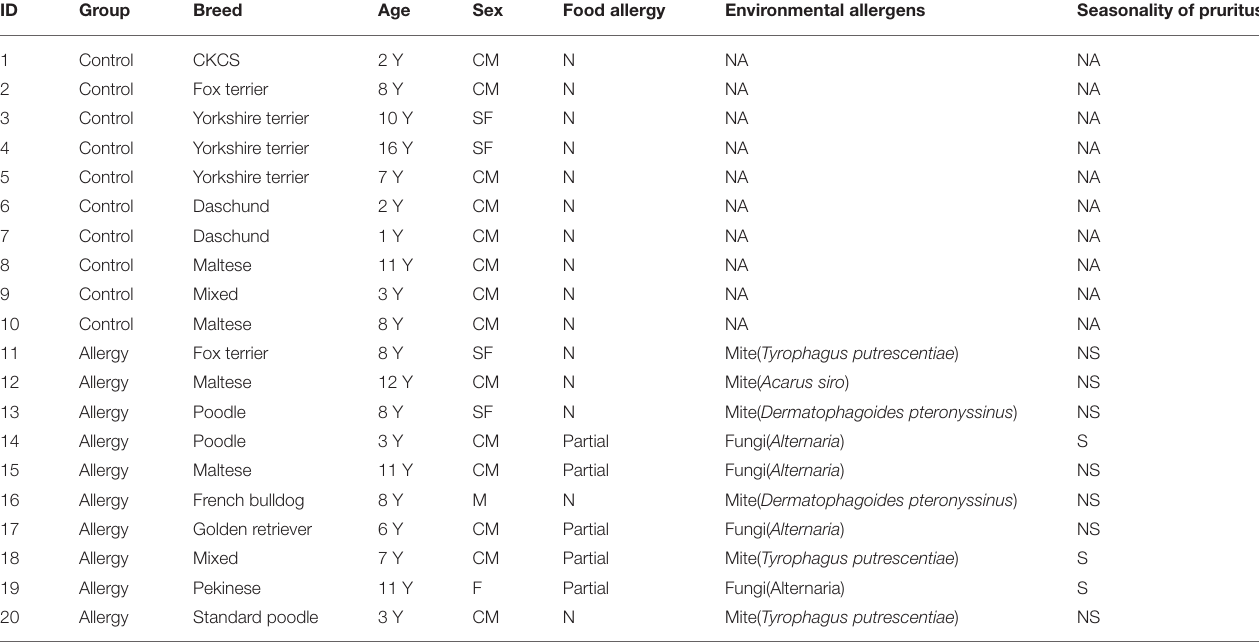
TABLE 2 | Signalment